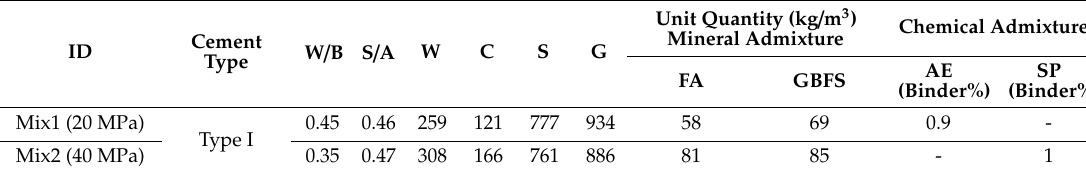
Table 1. Proportions of the concrete mixture groups 1 .